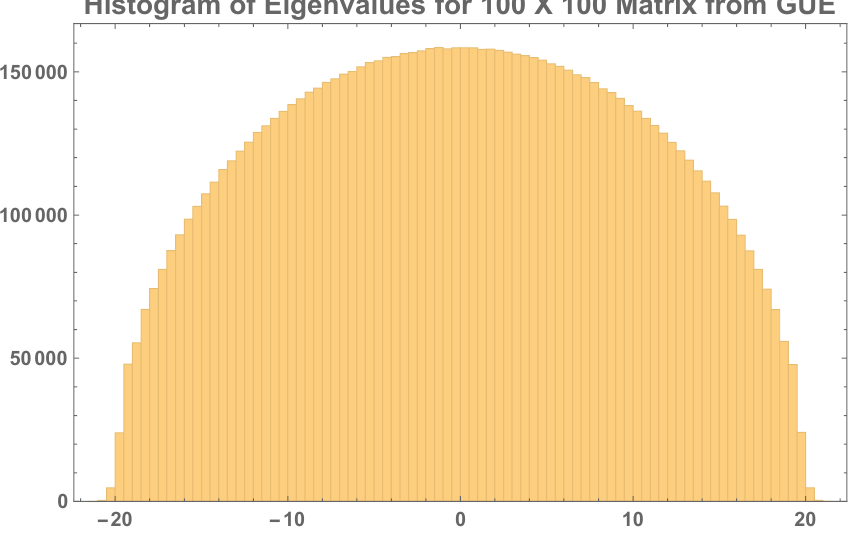
Figure 17 . Histogram for eigenvalues of a 100 × 100 random matrix pulled from the GUE. The histogram is generated from the eigenvalues of 10 5 random